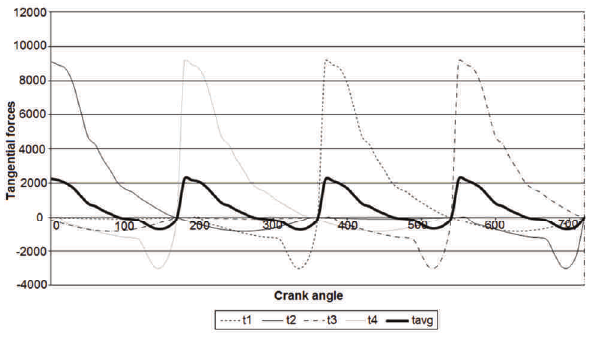
Fig. 1. Crank tangential forces in a smooth-running motor